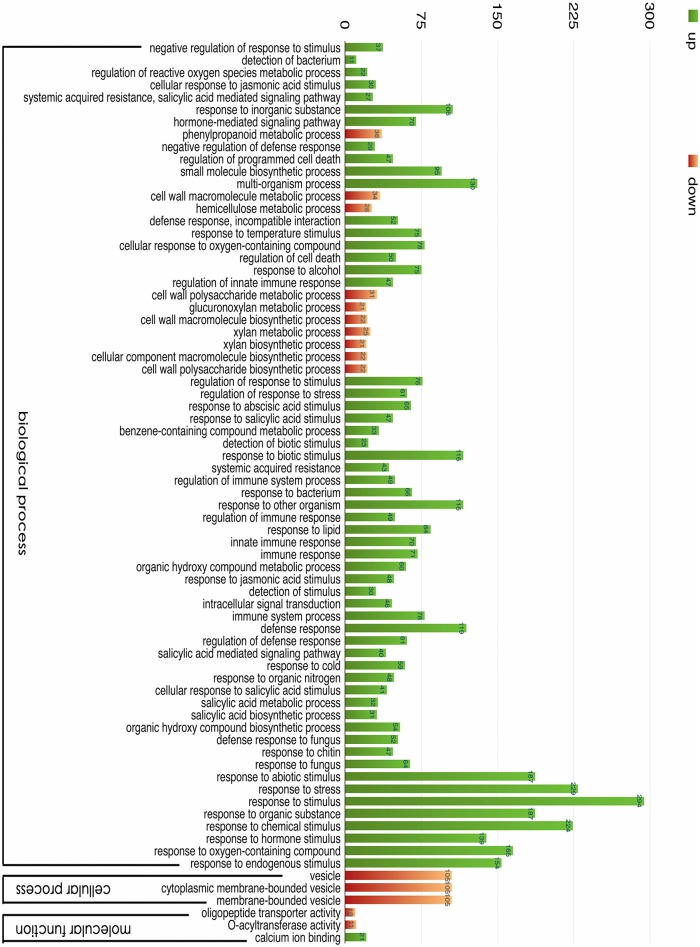
GO classification of the unigenes. The results are summarized for three main categories: biological process, cellular component, and molecular function. In total, 1445 DEGs with BLAST matches to known proteins were assigned to GO categories.